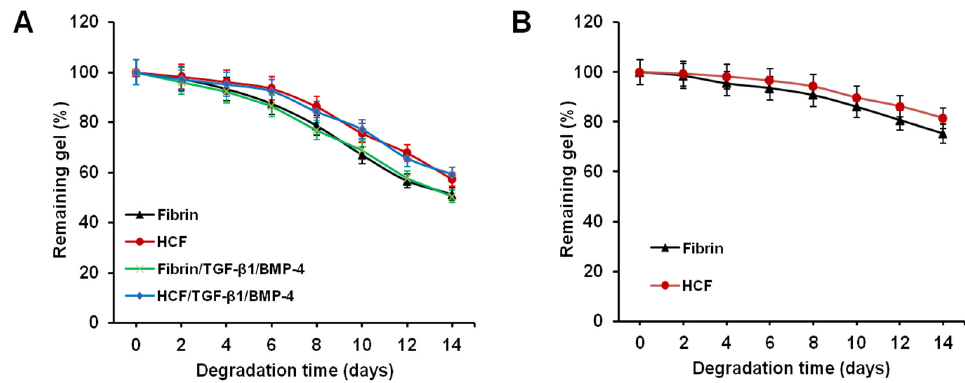
Figure 3. In vitro degradation kinetics of fibrin and HCF hydrogels. ( A ) Enzyme-mediated degradation of the hydrogels. ( B ) Cell-mediated degradation of the hydrogels.